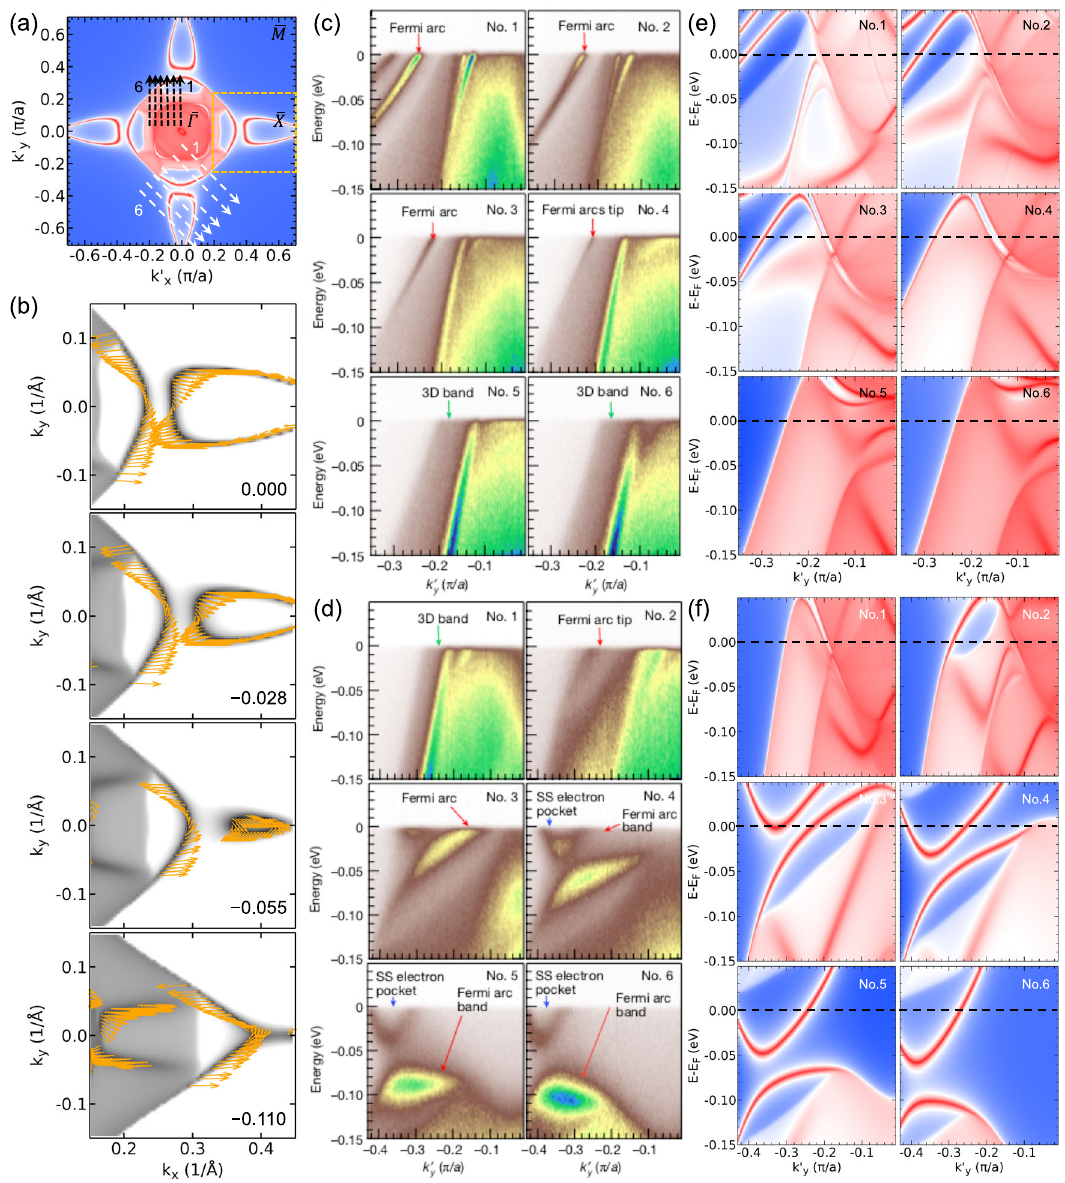
Fig. 4 Comparison between NdBi 2q (001) surface states and angle-resolved photo-electron spectroscopy (ARPES). a 2D surface Fermi surface (SFS) on 2q (001) labeled with two sets of cuts in black and white dashed lines, and an orange box focusing on the surface state pairs. b SFS zoomed in the orange box of ( a ) for the surface hole Fermi arc and electron pocket with the spin texture (in-plane components of the expectation value of spin weighted by the SFS) indicated by the orange arrows. The different energies are labeled in eV. c , e Comparison between ARPES and the calculated spectral functions at the cuts (black dashed lines in ( a )) of 0.03, 0.08, 0.12, 0.14, 0.18, and 0.20 in the unit of the nonmagnetic surface Brillouin zone. d , f Comparison at cuts in the other direction (white dashed lines in ( a )) at 0.03, 0.09, 0.17, 0.22, 0.24, and 0.27. All energies are downward shifted by 0.010 eV from the Fermi energy (E F E F + 0.014 eV in Fig. 5d, e, there are small protrusions along the (cid:1) Γ (cid:1) M - direction connecting the hole SS on both the top and bottom surfaces. After zooming in Fig. 5f, g with the surface-only con- tribution, it turns out that the hole SS connects the projections of outer WPs (green circles), but not the inner WPs (black squares).